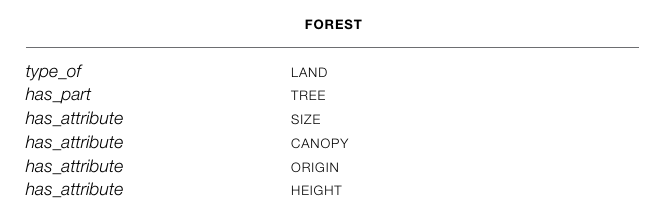
TABLE 7 | forest definitional